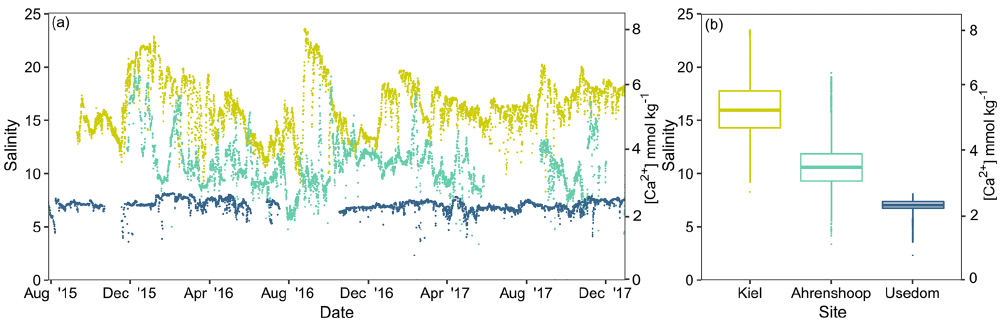
Figure 2. Field salinity and [Ca 2 + ] at the three Baltic Sea sites from August 2015–December 2017 (a) . Salinity data are derived from deployed CTD loggers and [Ca 2 + ] was calculated from these values (Sect. 2.1). Boxplots depict median salinity and interquartile ranges excluding outliers (b)